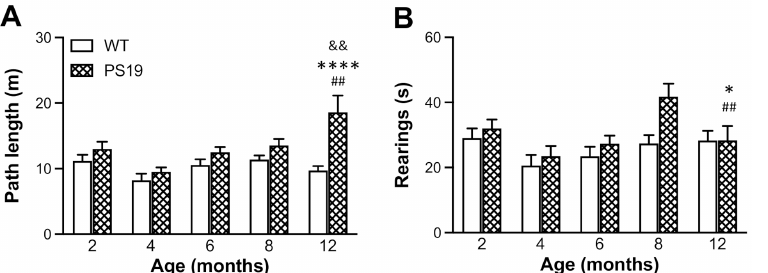
Figure 3. Mean ( ± SEM) path length (m, A ) and duration of rearings ( B ) of male wild-type (WT) and PS19 mice at 2, 4, 6, 8 and 12 months of age in the open field test ( n = 11–15/genotype/age). && indicates a significant genotype and age interaction at p < 0.01. * indicates a significant genotype effect at * p < 0.05 or **** p < 0.0001. ## indicates a significant age effect at p < 0.01.